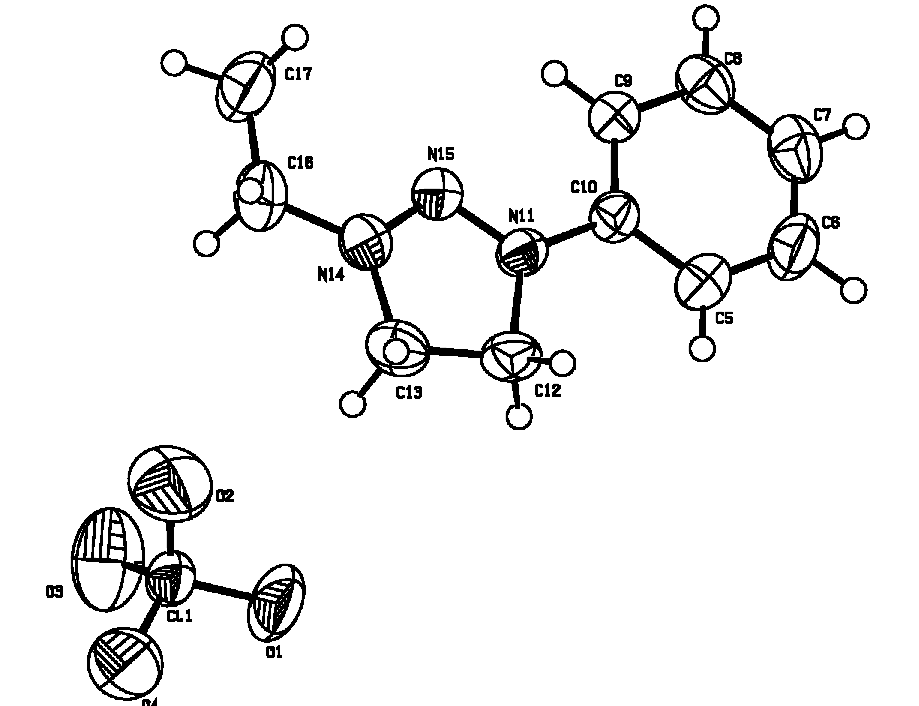
Fig. 2 ORTEP of the molecule at 50%